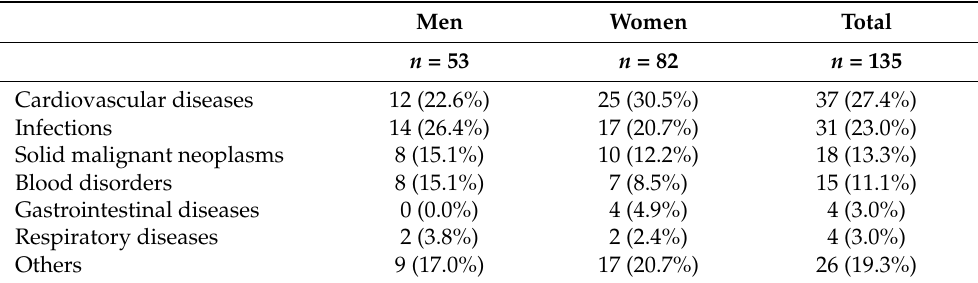
Table 3. Underlying causes of death when SD was listed as a non-underlying cause of death, for the period